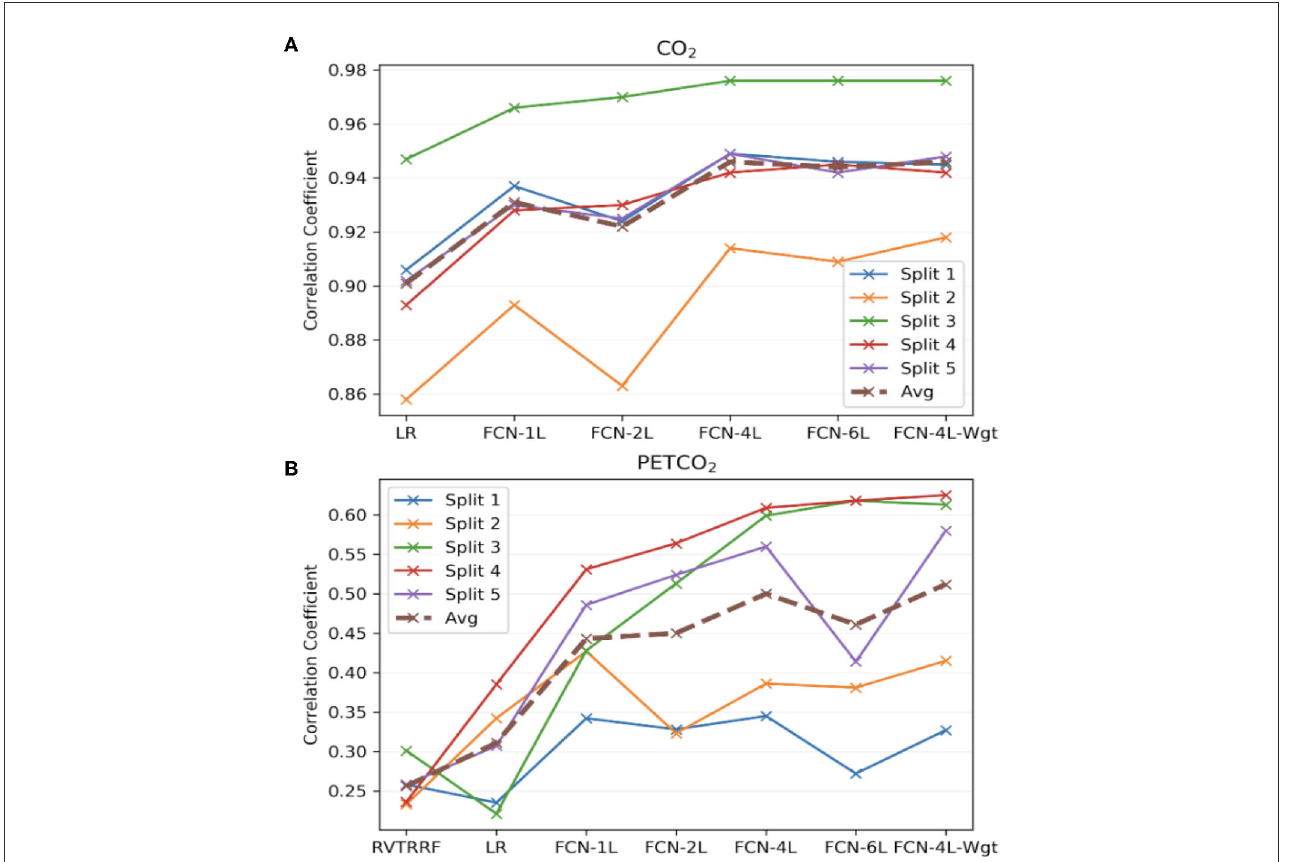
FIGURE7 Model performance across the five splits. The correlation coefficients (r) obtained across the five splits and their average for all the models, for (A) CO 2 and (B) PETCO 2 prediction. The split number is the same as the splits shown in Figure